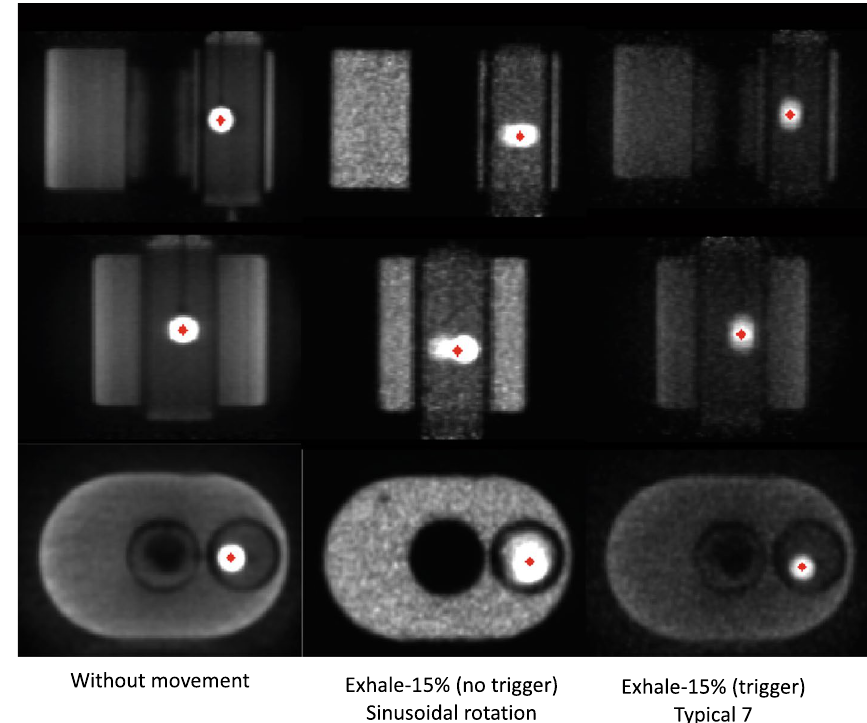
Fig. 17 Coronal, sagittal and axial PET images for reference static protocol and the Exhale 15% (no trigger) for the Sinusoidal pattern with rotation and the Exhale 15% (trigger) for pattern Typical 7. Reference segmentations are shown in